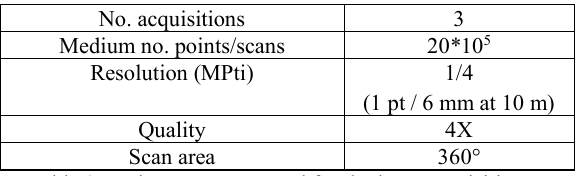
Figure 1. The borders of San Severino Marche